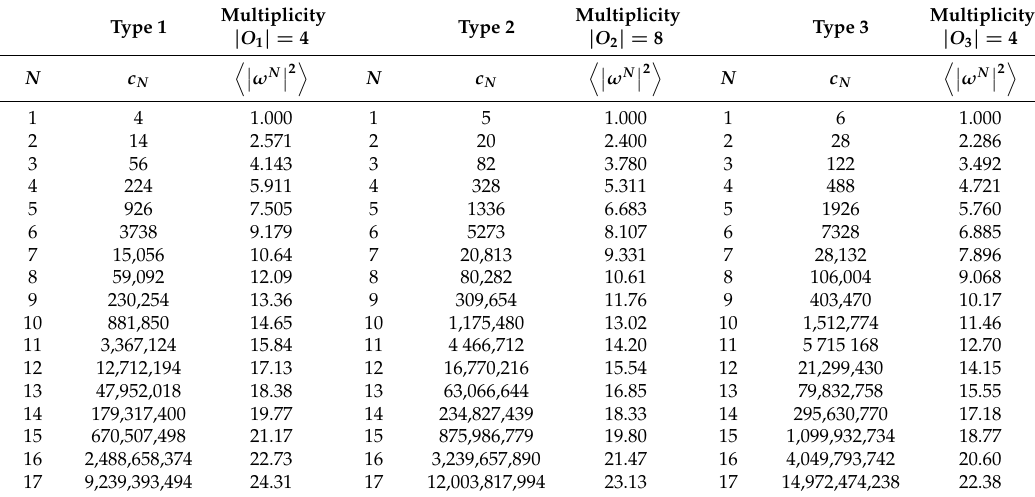
√ √ 2 × 0.5 2. The second column of the first table is the